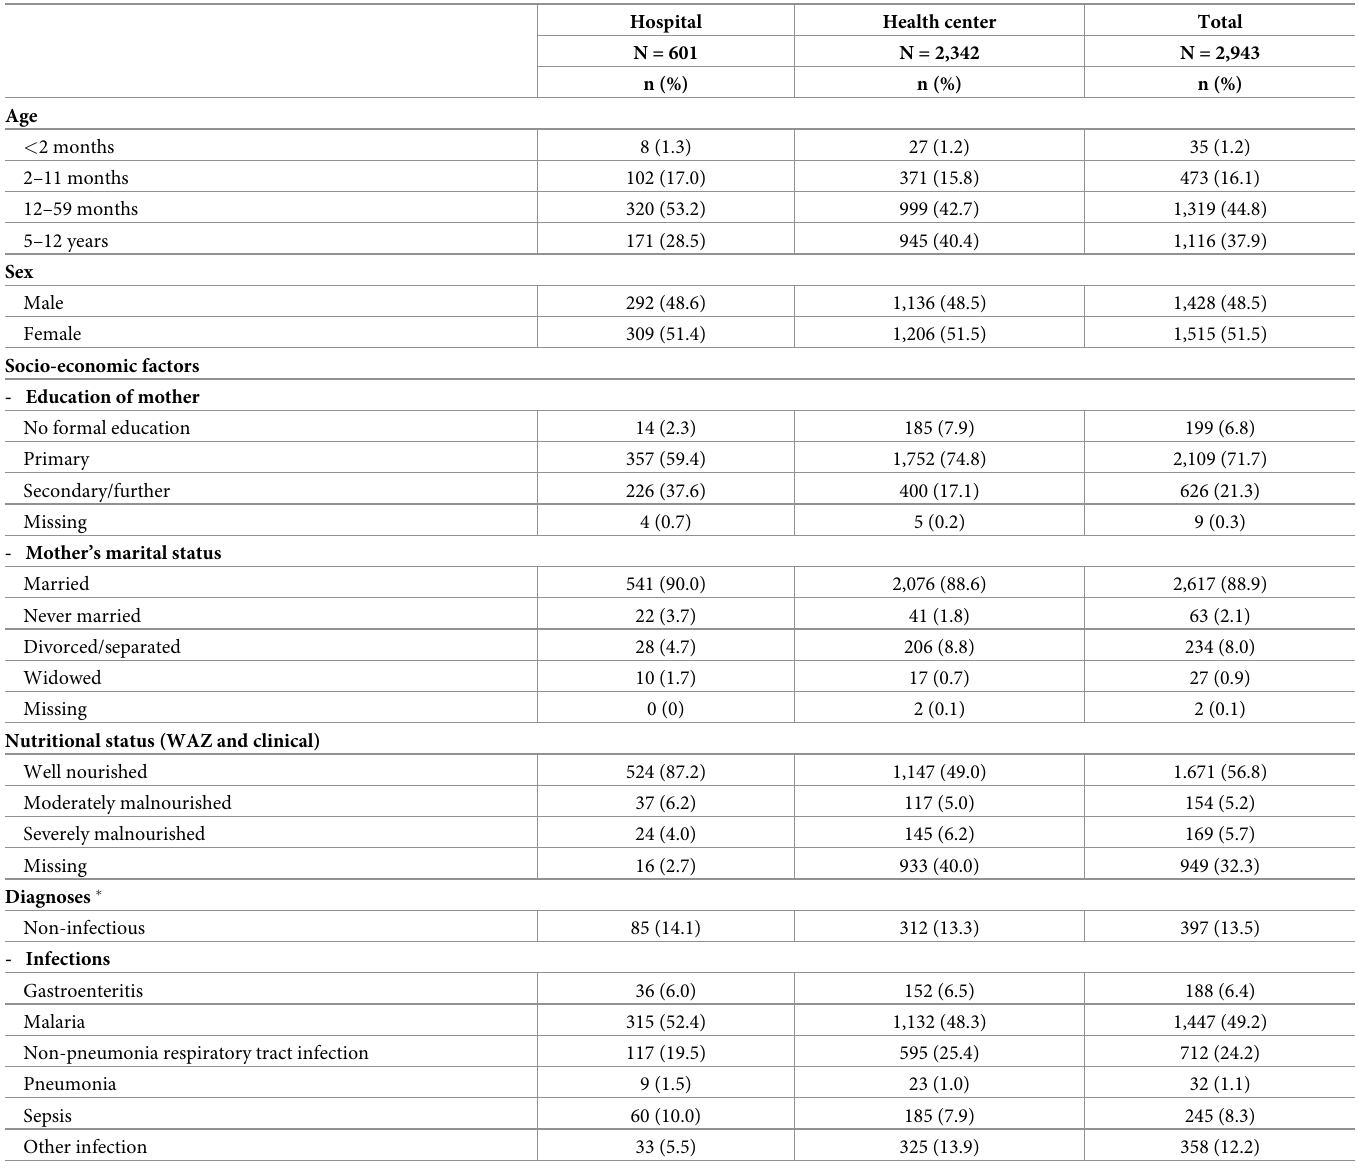
Table 1. Baseline characteristics of recruited